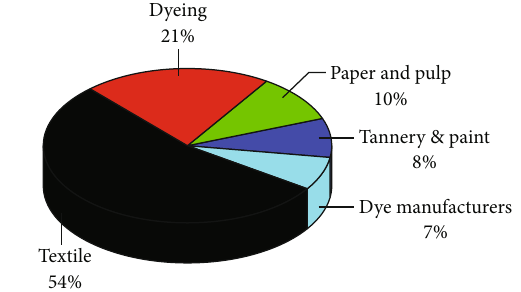
Figure 5: Relative proportion of dye e ffl uents added by various industries to the